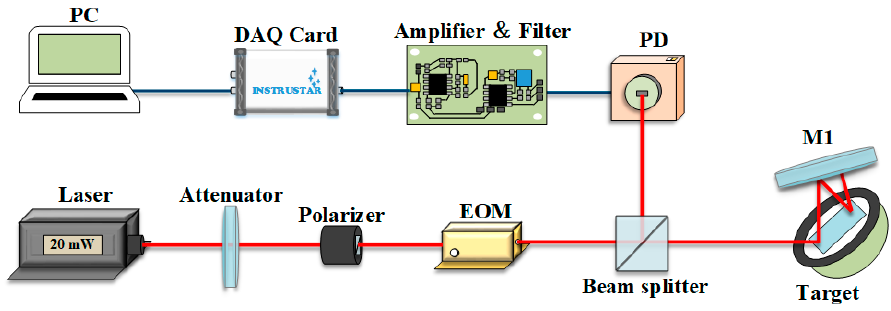
Figure 5. Setup of the experiment system.